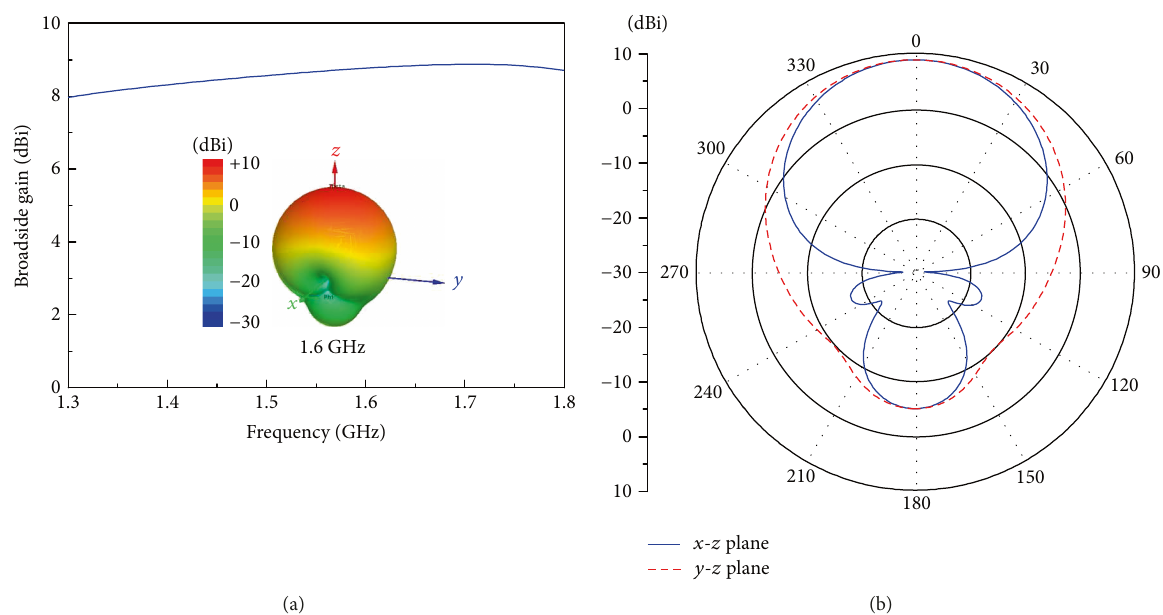
Figure 3: Simulations of the single-dipole antenna loaded with parasitic patches: (a) broadside gain, together with 3D 1.6GHz total-gain pattern and (b) 2D 1.6GHz radiation